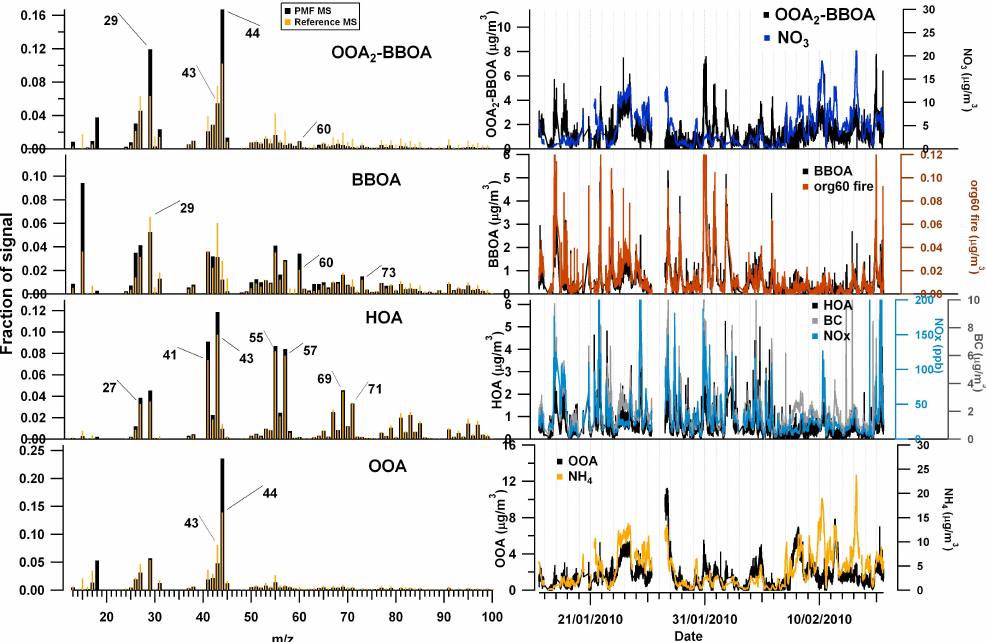
Fig. 4. PMF results: time series and mass spectral comparisons (GOLF site). Reference spectra are provided by Ng et al. (2010) for BBOA, HOA, and COA, and by DeCarlo et al. (2010) for OOA 2 -BBOA.